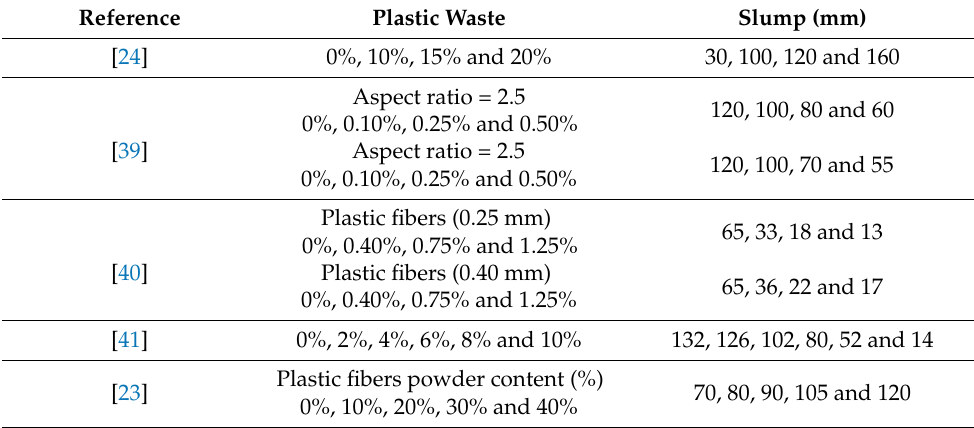
Table 2. Workability of Concrete with Substitution of Plastic